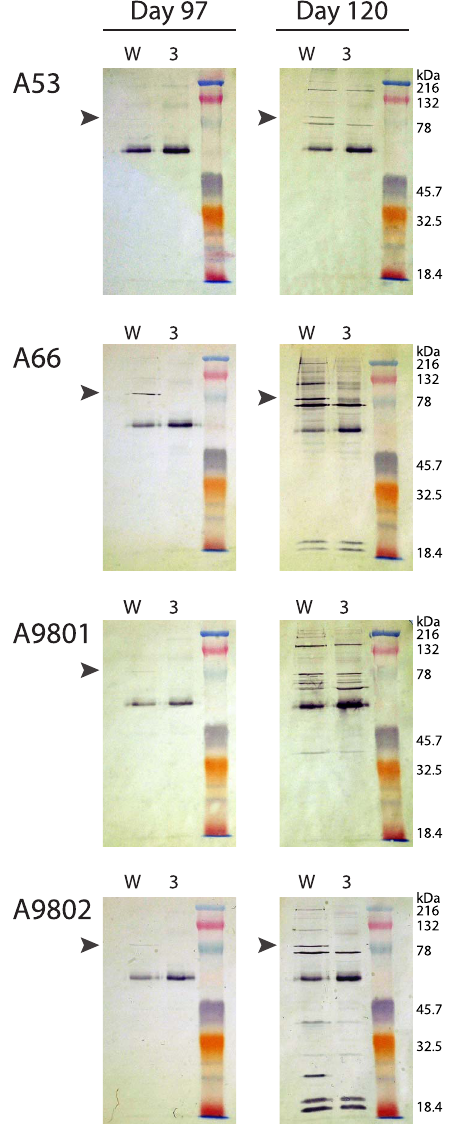
Figure 6. Reactivity of Aotus sera with parasite proteins. Schizont extracts from the Wellcome (W) and 3D7 (3) isolates were probed by Western blotting with sera from all four immunized animals. Serum samples from day 97 (pre-challenge) and day 120 (post challenge) from each animal were tested in parallel on contiguous parts of the same membrane. Immunized animal code numbers are shown on the left of each panel. Arrowheads indicate reactivity with the N-terminal p83 proteolytic fragment of MSP-1. The dominant 50 kDa band in all blots is the heavy chain of human IgG, recognized by the secondary reagent (HRP conjugated anti-human IgG heavy